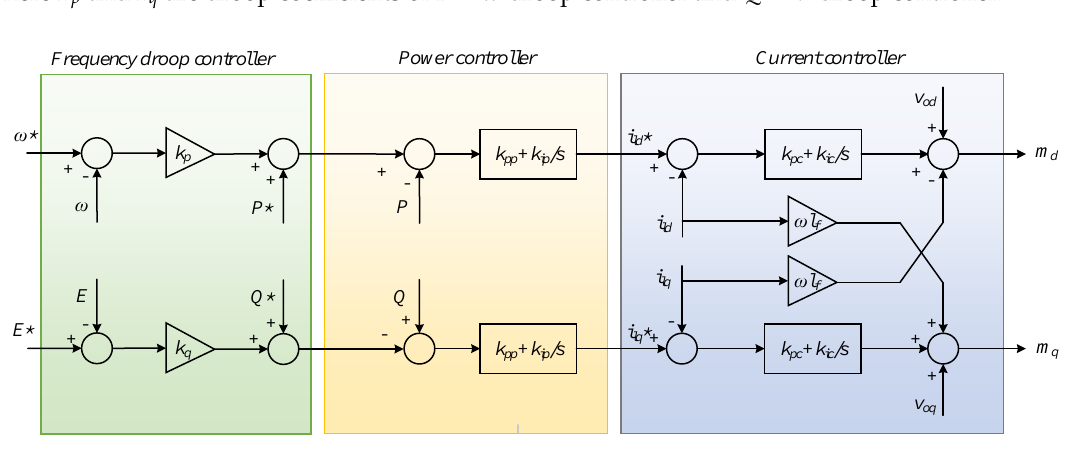
Figure 6. Control scheme of VSG controller.